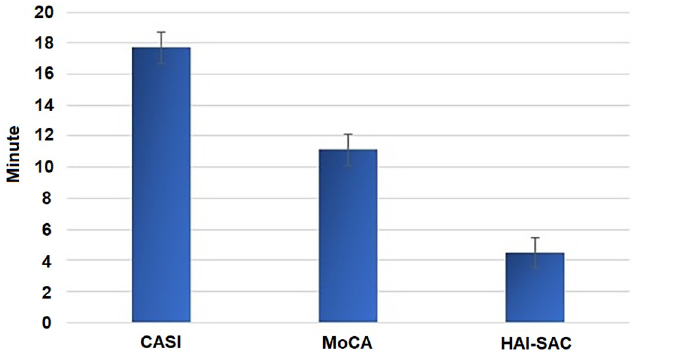
Fig 2. Test time of the screening neuropsychological